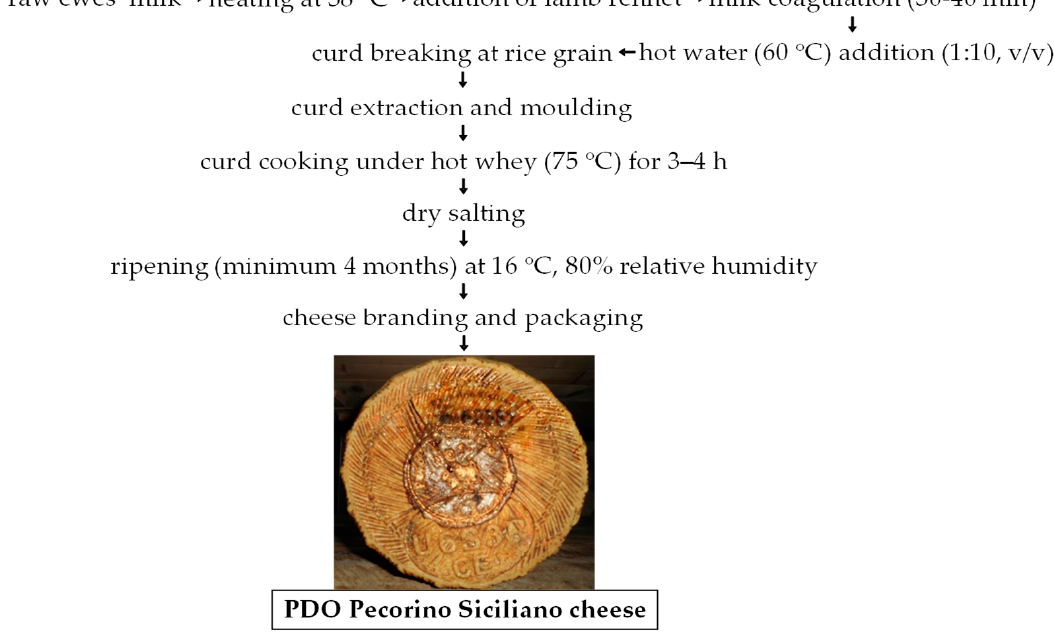
Figure 1. Main steps of protected designation of origin (PDO) Pecorino Siciliano cheese production. Adapted from Settanni et al.